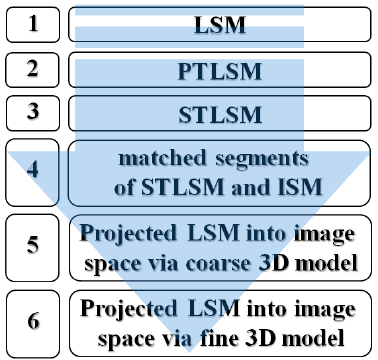
Figure 22. Product chains in the process of coinciding the LSM with the ISM.